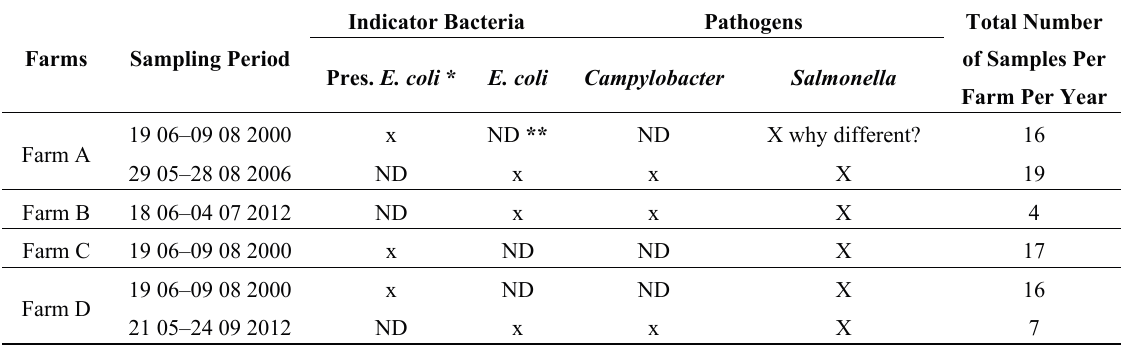
Table 1. Sampling periods and parameters analysed for the separate